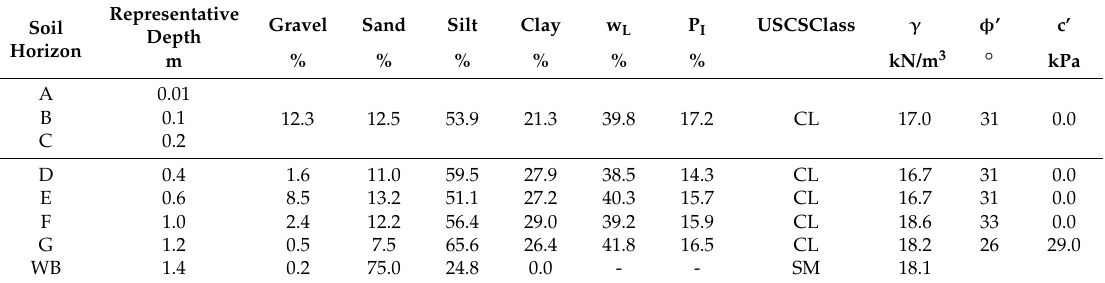
Table 1. Main geotechnical, physical, and hydrological properties of the soils at various levels [24]. Representative Gravel Sand Silt Clay w Soil Depth Horizon